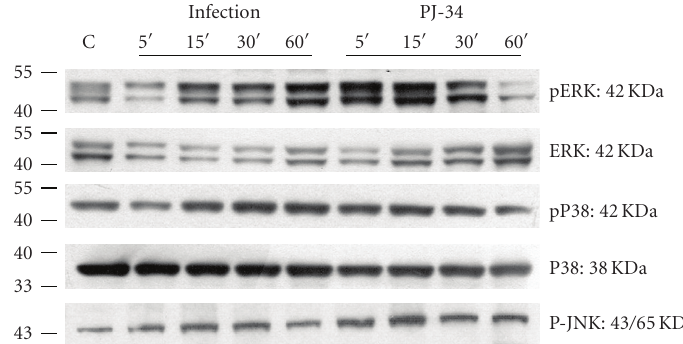
Figure 3: E ff ect of PJ-34 on Salmonella-activated intracellular signals . Caco-2 cells were left untreated, or treated with 40 μ M PJ-34, and then infected with wild-type S. Typhimurium strain SL1344 for the times indicated. Activations of the ERK, JNK, and p38 were analyzed in whole cell protein by immunoblotting with antibodies to phosphorylated (p) ERK, JNK, and p38 and total ERK and p38. The activation of ERK was enhanced by PJ-34 but not the JNK and p38. The results shown are representative of 3 separate experiments.